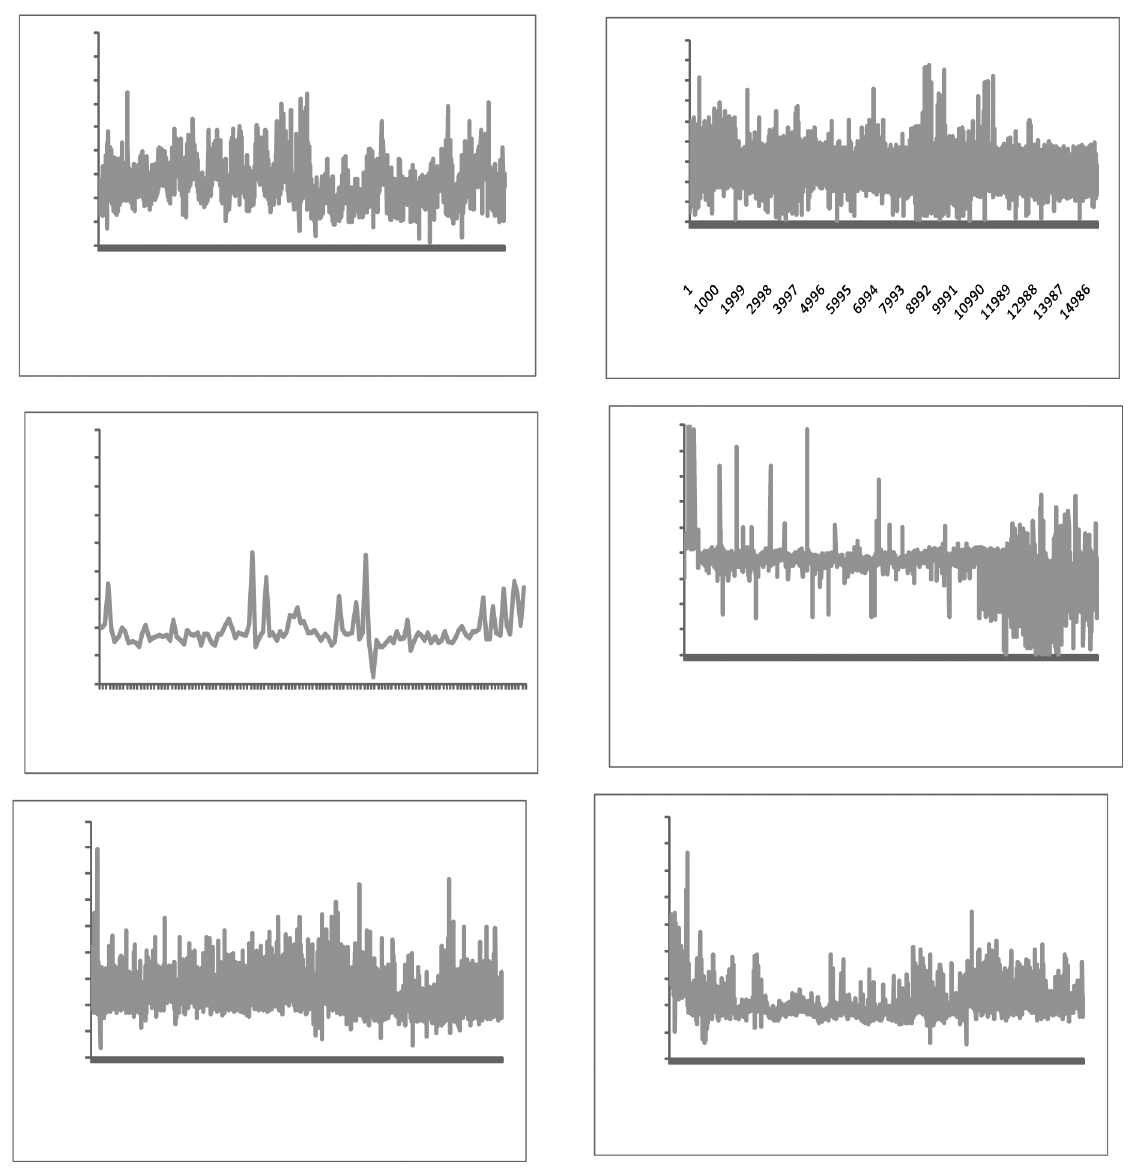
Figure 8. Daily distribution of total cloud liquid water content (kg/m 2 ) obtained from radiosonde measurements in the six climatic